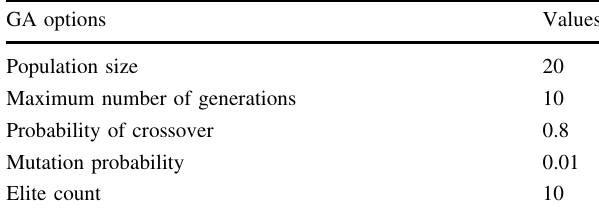
Table 2 Options set for the genetic